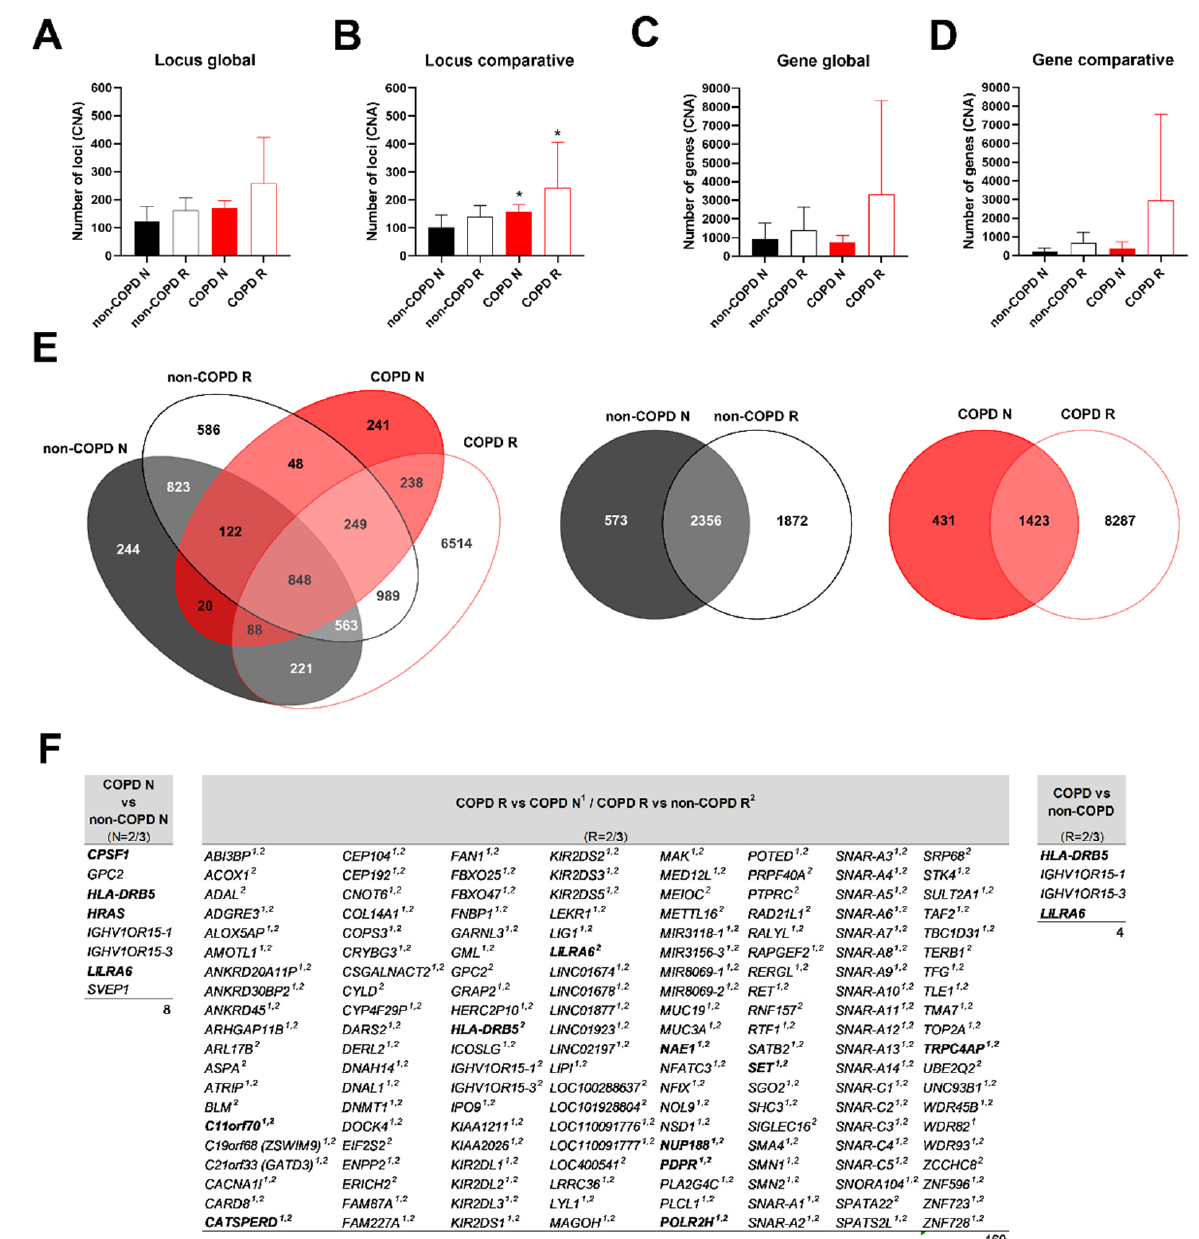
Figure 3. Identification of copy number alterations in COPD microdissected remodelled epithelia. Histograms (mean ± SEM) showing the number of identified loci or genes with CNA according to respiratory status and tissue morphology (N: non-remodelled; R: remodelled). ( A ) Identical loci (same start and end positions) between N and R were retained ( B ) or removed. ( C ) Identical genes between N and R were retained ( D ) or removed. *, p < 0.05 COPD N vs. non-COPD N, and COPD R vs. non-COPD N. ( E ) Venn diagrams of overlapping genes with CNA in the global repartition. ( F ) Lists of potential frequent genes with CNA in COPD epithelia (1; COPD R vs. COPD N; 2, COPD R vs. non-COPD R). Genes presenting a CNA for 2 or 3 COPD samples (N or R = 2/3 (bold)). See Supplementary Materials: Figure S6 for copy number description.